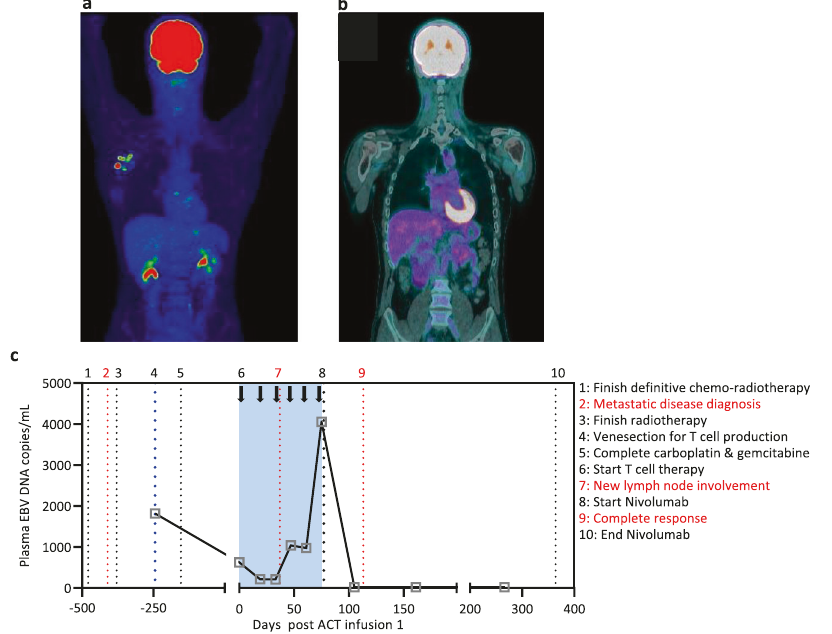
Fig. 1 Tumor burden before and after ACT and checkpoint inhibition. a PET/CT demonstrating right axilla nodal metastases. b Re-staging PET/CT from October 2018 showing complete resolution of disease in the right axilla. c Plasma EBV DNA load was measured using standard quantitative PCR designed to target the BamHI-W region. Patient treatment and clinical diagnosis relative to the administration of EBV-speci fi c ACT and nivolumab are overlaid. The period of ACT is represented by the blue